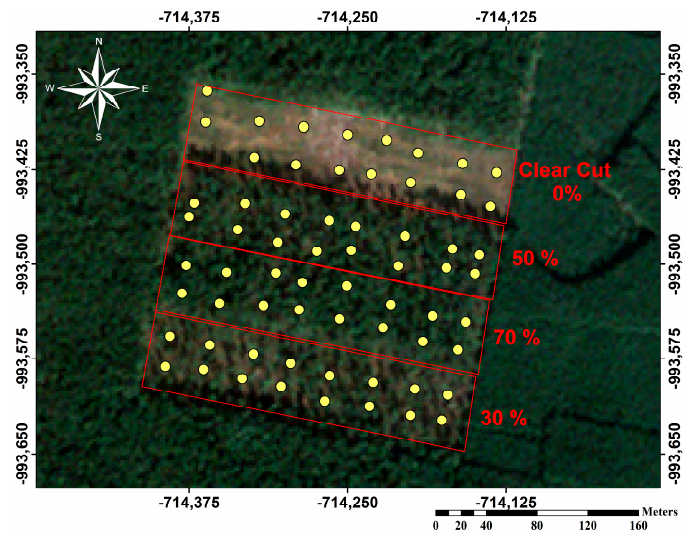
Figure 2. Scheme of the study area showing the locations of the plots in different percentages of canopy cover. Within the whole plot, 64 measuring points was ascertained.